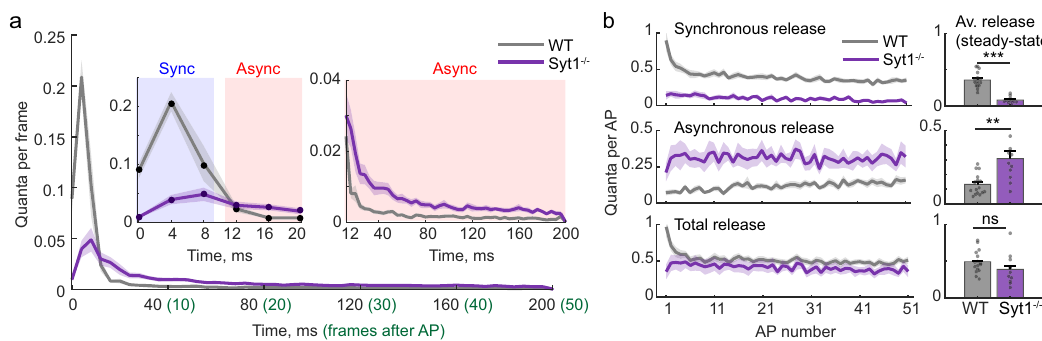
Fig. 2 Comparison of vesicular release kinetics in wild type (WT) and Syt1 − / − neurons. a Average time courses of evoked vesicular release in WT and Syt1 − / − (quanta per frame). The traces were obtained by fi rst averaging in each imaged bouton the number of quanta detected in individual frames following each of 51 action potentials in the train (frames 0 to 50, 4 ms/frame). This was followed by calculating the cell-averaged responses (range 21 – 162 boutons per cell) and fi nally the mean responses across all recorded neurons (shaded areas represent SEM among the recoded cells). Based on the distinct biphasic time-course of vesicular release in wild-type neurons, the time threshold between synchronous and asynchronous release events was set at 10 ms after the somatic action potential ( i.e . at the border between 2nd and 3rd frames, see main text for details). b Comparison of synchronous, asynchronous and total release in wild type and Syt1 − / − neurons during the 5 Hz stimulation train. Left, traces represent the average number of vesicular quanta released at each action potential in a single presynaptic bouton (mean ± SEM, shaded area). Right, distributions of mean synchronous, asynchronous and total release ef fi cacies at the steady state (between action potentials 20 and 51) among the recorded cells (mean ± SEM). ( a , b ) Wild type, N = 16 cells from 5 culture preparations; Syt1 − / − , N = 11 cells from 4 culture preparations ** p < 0.01, *** p < 0.001, ns p = 0.09, two-tailed Mann – Whitney U test (for exact p values and for further details of statistical analysis see SourceData.xlsx fi